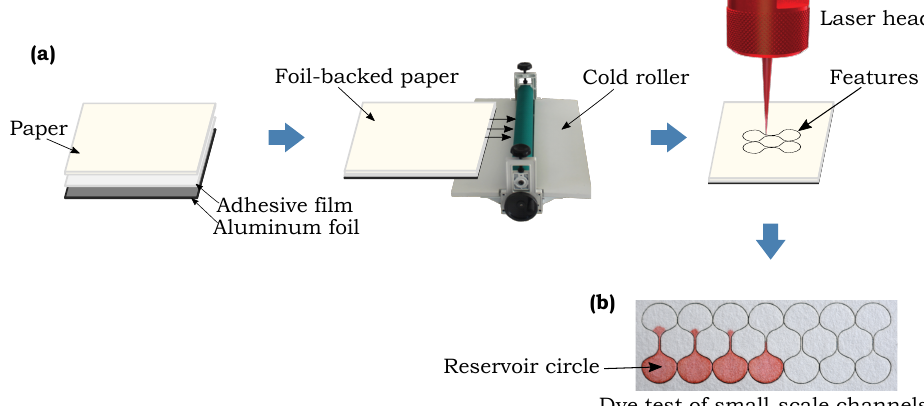
Figure 1. ( a ) Schematic of the fabrication technique used to generate small-scale features in the different paper types. ( b ) Overhead view of a dye flow test with the fabricated small-scale channels.